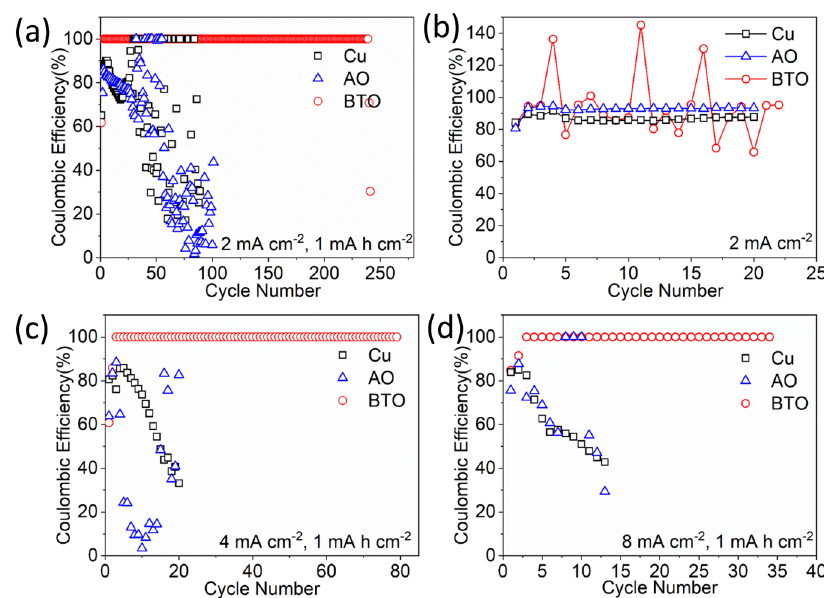
Fig. 3 Half-cell performance of the anode-free Cu and AO and BTO scaffolds versus a Li metal electrode. Lithium Coulombic ef fi ciency a with a fi xed areal plated capacity of 1 mA h cm − 2 and stripping terminated by reaching the plated capacity or a 1 V vs Li/Li + voltage cutoff b with stripping terminated by a 1.0 V vs Li/Li + voltage cutoff at 2 mA cm − 2 . Coulombic ef fi ciency for cells performed at the current density of c 4 mA cm − 2 and d 8 mA cm − 2 with the anode-free half-cell cycling protocol